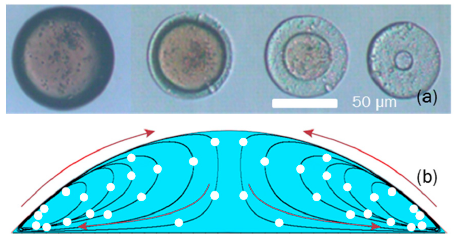
Figure 4. ( a ) The formation process of photonic crystal toroidal. ( b ) The schematic of droplet extraction before forming toroidal.